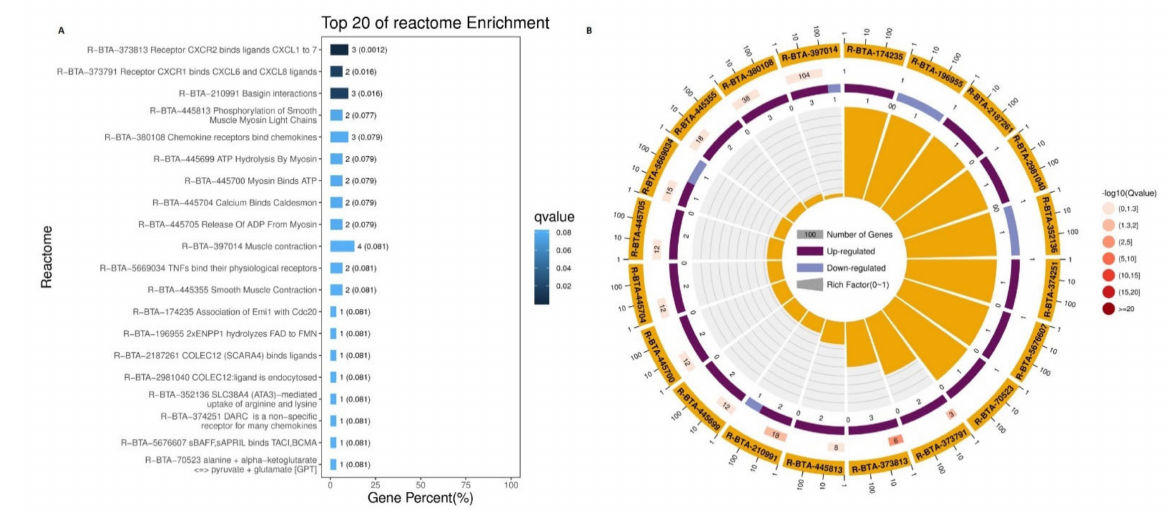
Figure 10. Top 20 reacrome enrichment pathways. ( A ) Reactome enrichment bar graph: the top 20 reactome channels with the smallest Q value to plot; the ordinate is the reactome channel, and the abscissa is the percentage of the number of reactome channels in all the DEGs. The darker the color, the smaller the Q value. The value on the column is the number of reactome channels and the Q value. ( B ) Reactome enrichment circle diagram: the first circle: the top 20 reactome pathways of the enrichment; outside the circle is the coordinate ruler of the number of genes. The second circle: the number of the reactome pathway in the background gene and the Q value. The more the genes, the longer the bars, the smaller the Q value, and the redder the color. The third circle: the bar graph of upregulated gene ratio, wherein dark purple represents the upregulated gene ratio and light purple represents the downregulated gene ratio; the specific value is shown below. The fourth circle: each reactome pathway Rich factor value (the number of differences in the reactome channel divided by all the numbers); in terms of background grid lines, each grid represents 0.1.